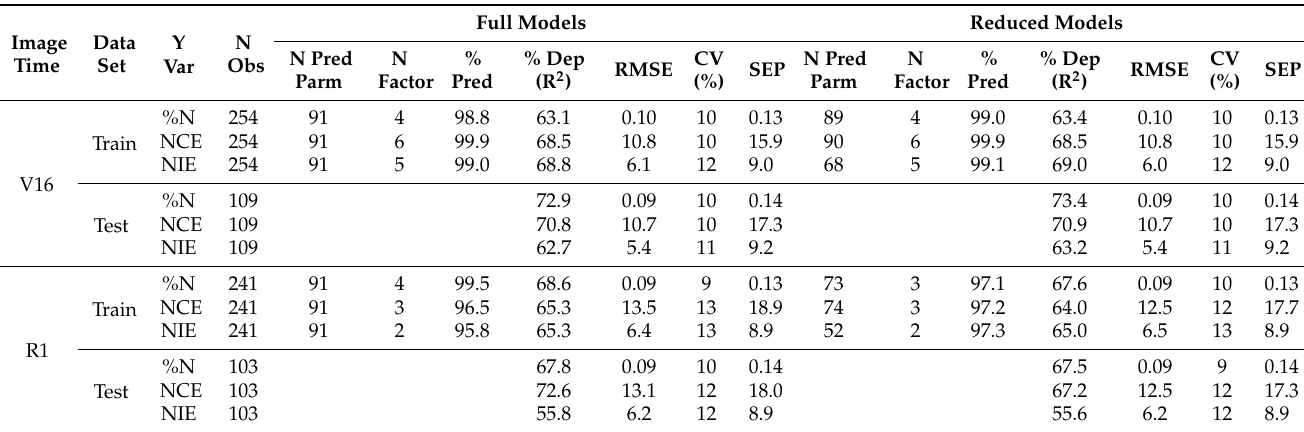
Table 1. PLSR models based on imaging obtained at V16 or R1 for predicting end-season %N, NCE or NIE in maize using models with all 91 predictors [including 89 hyperspectral bands] (“Full”) or a reduced number of bands